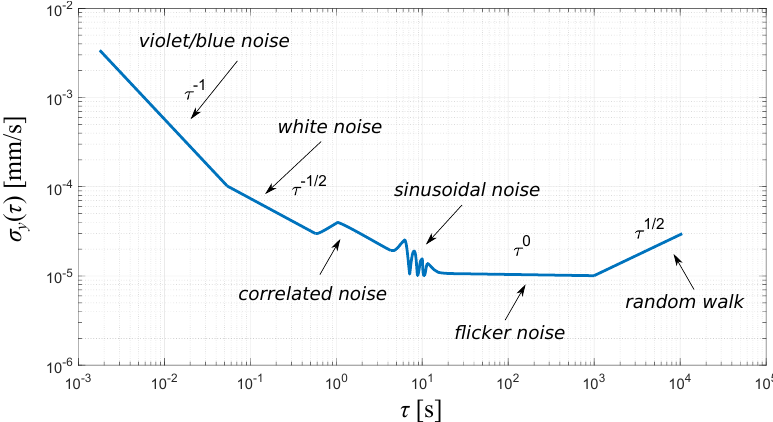
Figure 3. Schematic view on Allan Deviation log-log plot (axis values are for illustrative proposes).